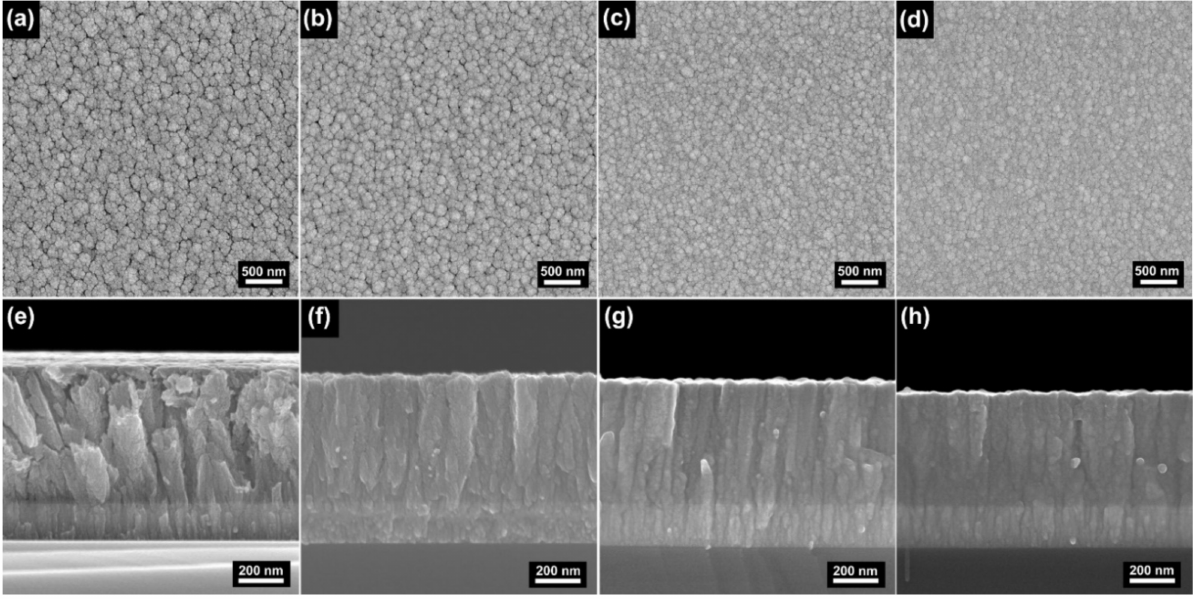
Figure 1. ( a – d ) Typical surface morphologies of the TaN x coatings deposited with different bias voltages: ( a – d ) are 0 V, − 100 V, − 200 V and − 300 V, respectively. ( e – h ) The corresponding cross section morphologies of ( a – d